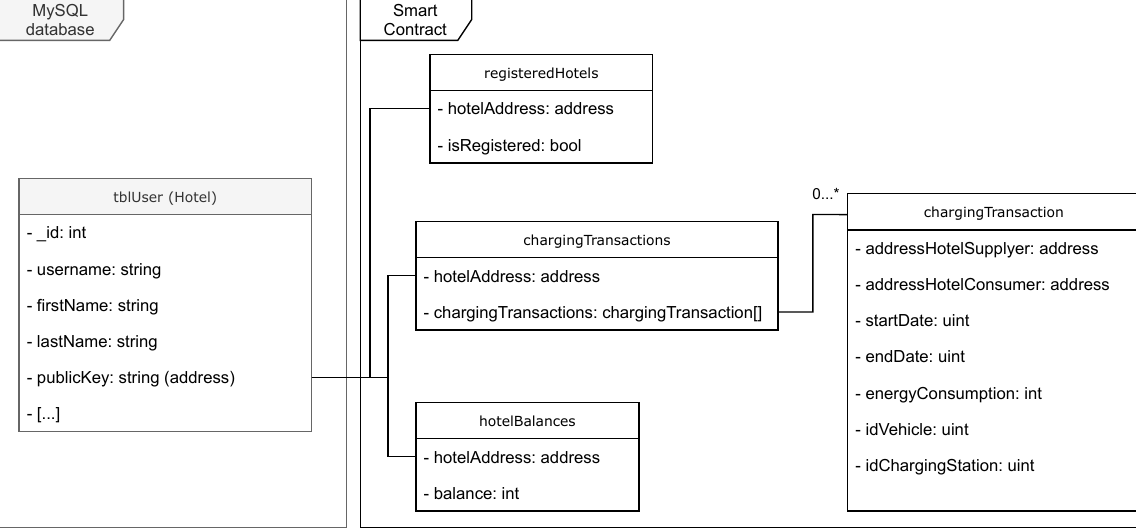
Figure 4. Smart contract class